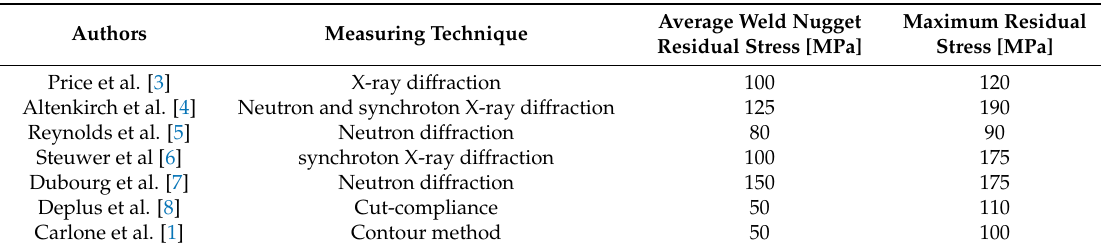
Table 1. Overview of selected residual longitudinal stress measurements on friction stir welding (FSW) 2024-T3 from literature.